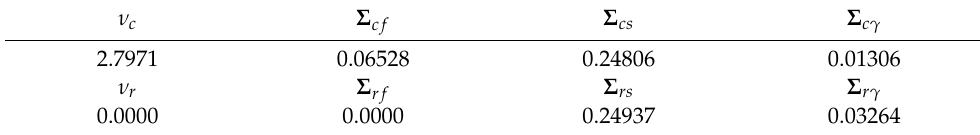
Table 4. One-group reflected reactor cross-sections data.